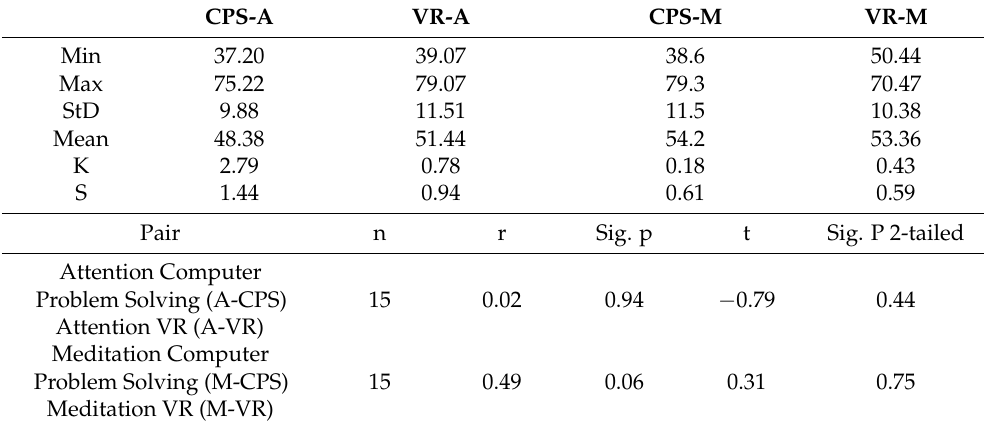
Table 8. t -test paired sample correlation results from computer problem-solving simulation vs. VR